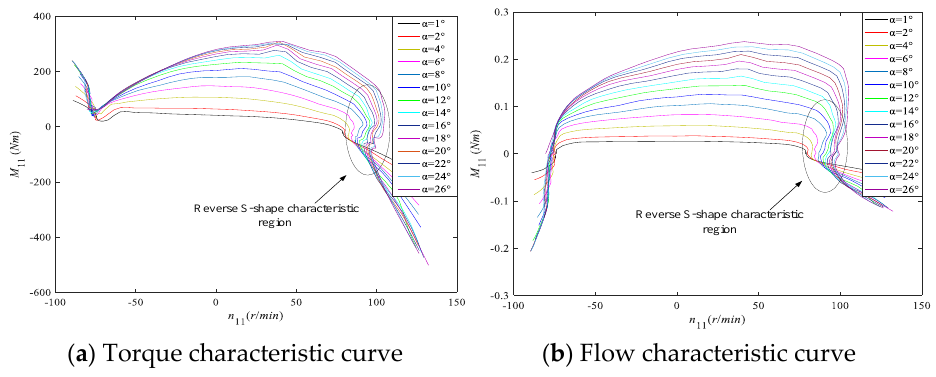
Figure 4. Full-characteristic curves of pump-turbine.